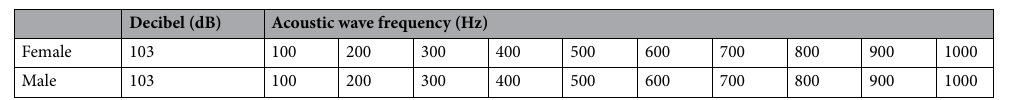
Table 2. Test conditions for the study of acoustic wave frequency effect on mosquito flight.